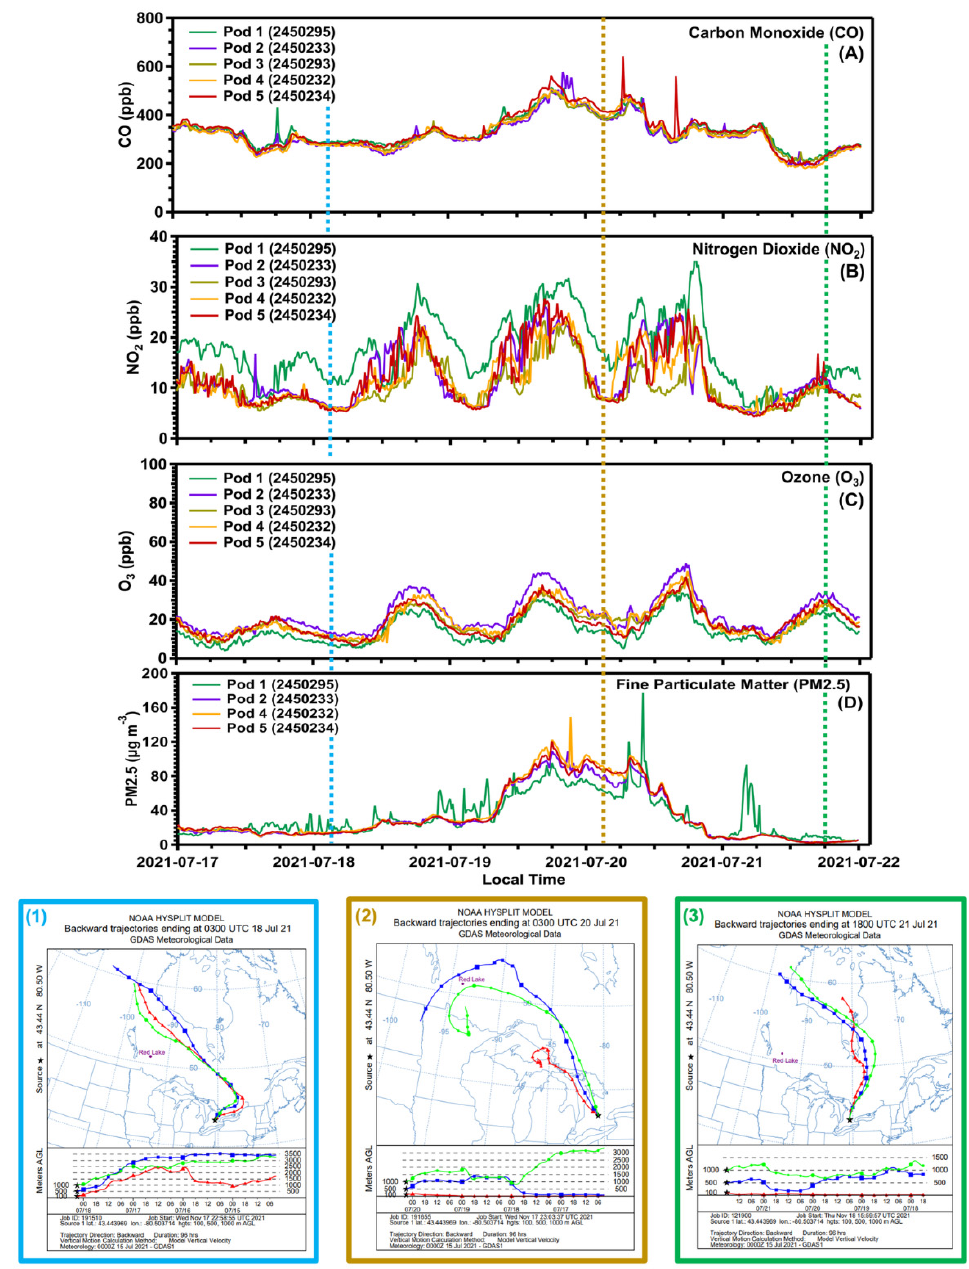
Figure 7. Time series of pollutant levels detected at all sites during wildfire episode for ( A ) CO, ( B ) NO 2 , ( C ) O 3 , and ( D ) PM2.5. Data presented is for 17–21 July 2021, where air quality warnings were issued in Southern Ontario on 19 July and 20 July 2021. Lower panel figures ( 1 – 3 ) show the back trajectory analyses from the NOAA Air Resources Laboratory HYSPLIT transport and dispersion model, including 96 h back trajectories ending in Victoria, Kitchener (UTM 17T 540140 E, 4810258 N). Three heights were chosen (100 m, 500 m and 1000 m) to account for a range of heights above Kitchener. The three sets of analyses show the back trajectory ending ( 1 ) before the event on 17 July 2021 at 22:00 (EST), ( 2 ) during the event on 19 July 2021 at 22:00 (EST), and ( 3 ) after the event on 21 July 2021 at 13:00 (EST) [47,48] .